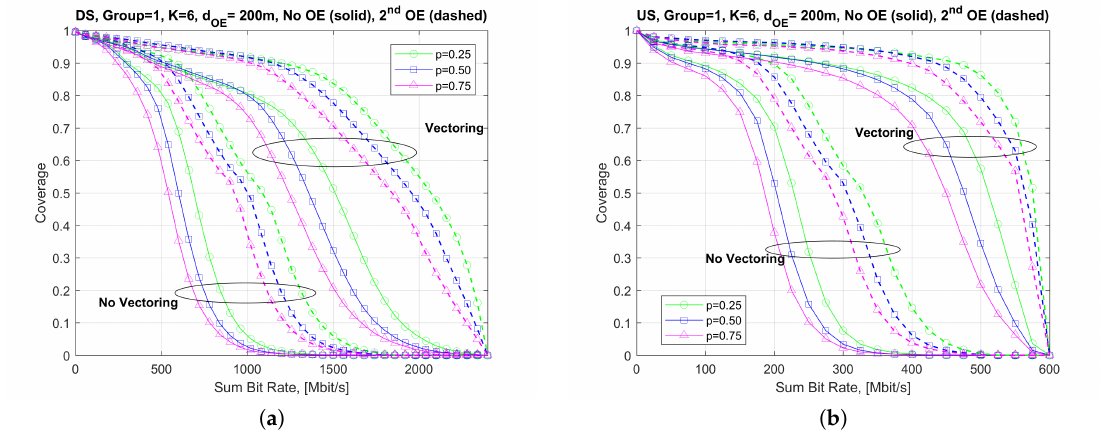
Figure 9. Sum bit rate coverage for group 1, d OE = 200 m—variable user activity factor p , with and without vectoring: DS ( a ) and US ( b